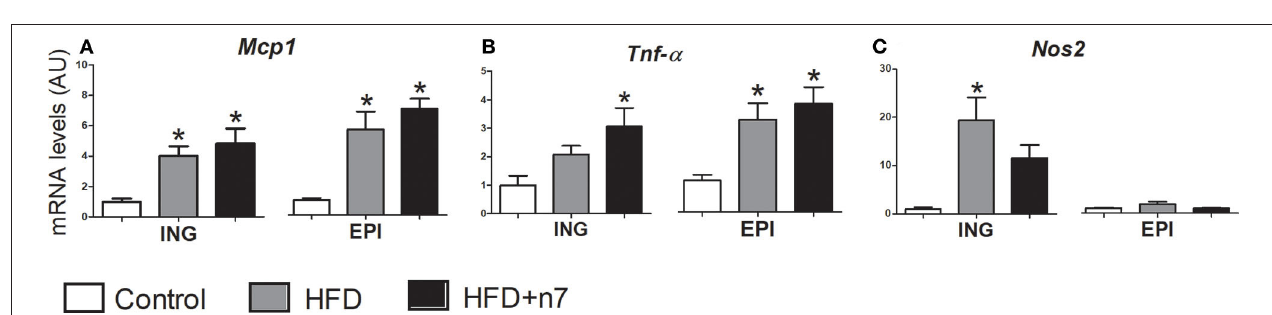
FIGURE 4 | mRNA levels of Cebpa (A) , Pparg (B) , Pref1 (C) , Cebpb (D) , Nrf1 (E) , Tfam (F) , Pgc1- α (G) , Prdm16 (H) , Sod1 (I) , Sod2 (J) , Gpx (K) , and Catalase (L) expressed by isolated adipocytes from ING and EPI fat depots in arbitrary units (AU), normalized by Gapdh . Results were expressed as mean ± SEM ( n = 12). Data were analyzed by one-way ANOVA. * p < 0.05 vs. control, # p < 0.05 vs. obese, + p = 0.05 vs. all groups.